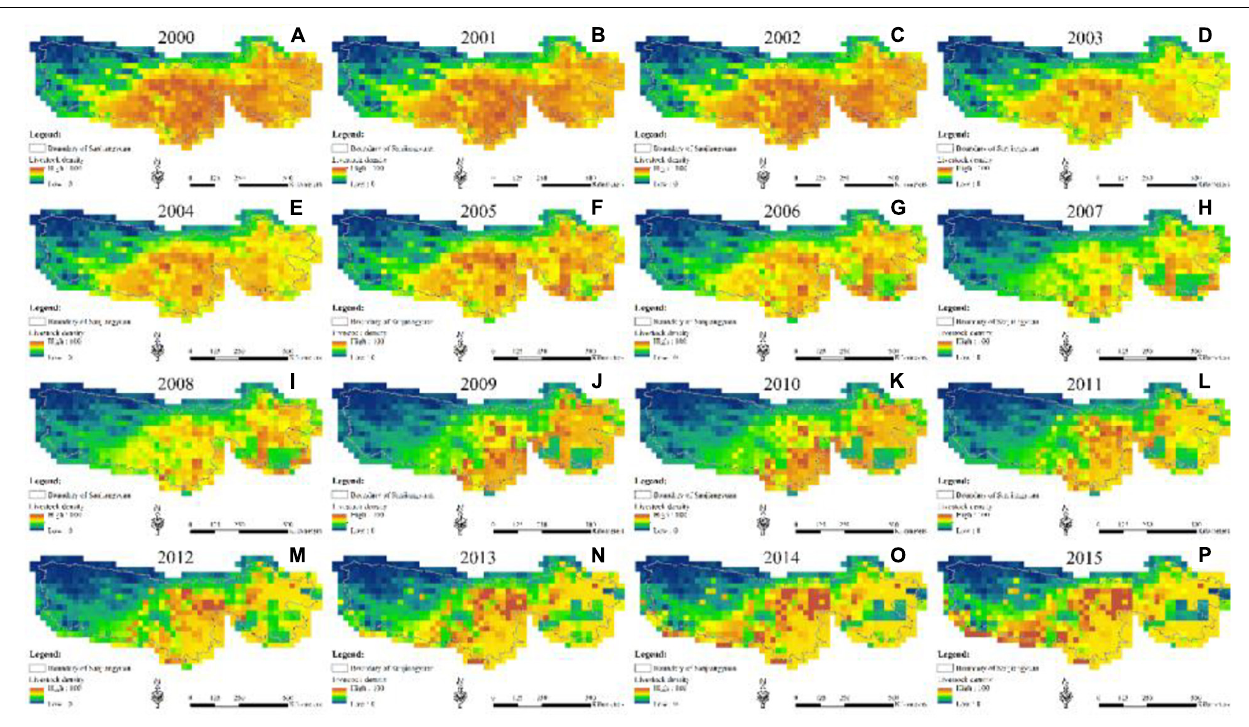
FIGURE 5 | Livestock density changes in 2000 (A) , 2001 (B) , 2002 (C) , 2003 (D) , 2004 (E) , 2005 (F) , 2006 (G) , 2007 (H) , 2008 (I) , 2009 (J) , 2010 (K) , 2011 (L) , 2012 (M) , 2013 (N) , 2014 (O) , and 2015 (P)